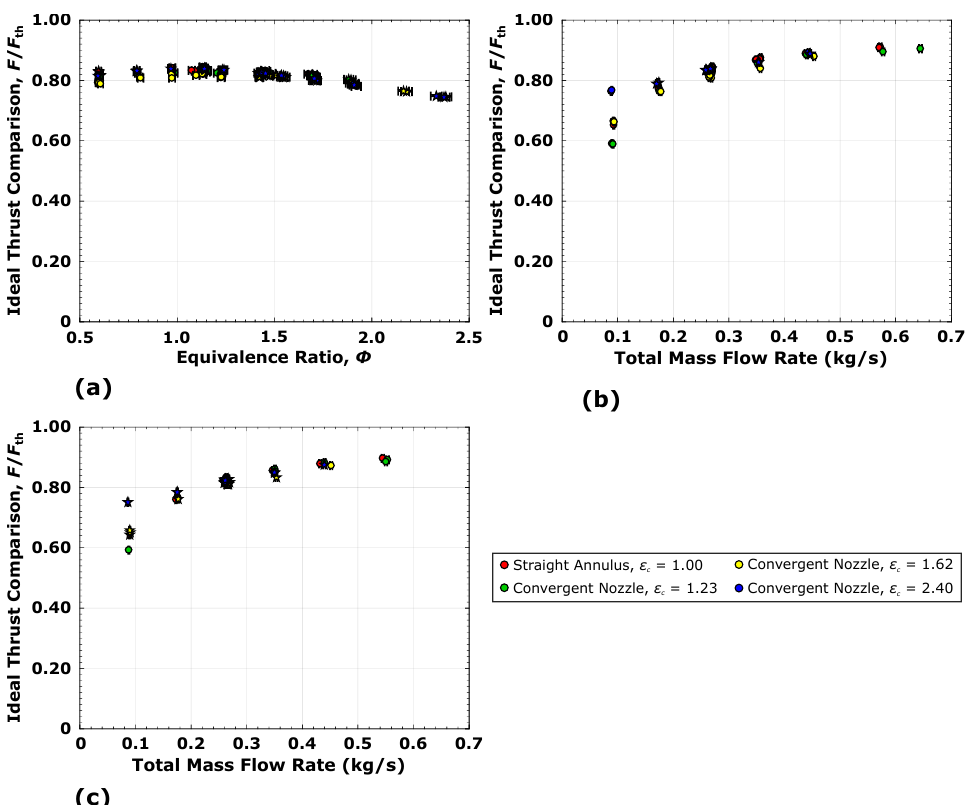
Figure 9. Ideal thrust comparison for the ( a ) equivalence ratio flow conditions at ˙ m tot = 0.272 kg/s, as well as the mass flow rate conditions for ( b ) φ = 1.15 and ( c ) φ = 1.5. Depending on the flow condition and convergent nozzle geometry, the engine operates in either a corotating ( • ) or counter- propagating mode ( (cid:63)